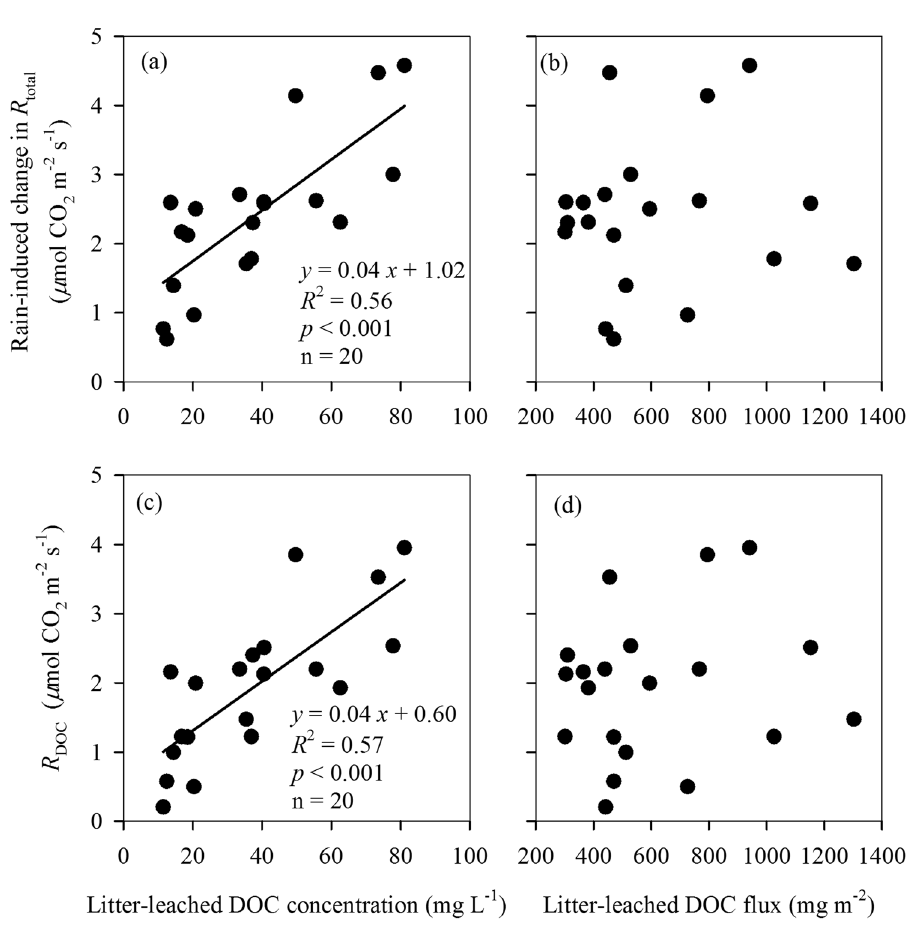
Figure 5. Relationships of rain-induced changes in total soil CO 2 flux ( R total ) and litter DOC-contributed soil CO 2 flux ( R DOC ) after simulated rains with the concentrations and total flux of litter-leached dissolved organic carbon